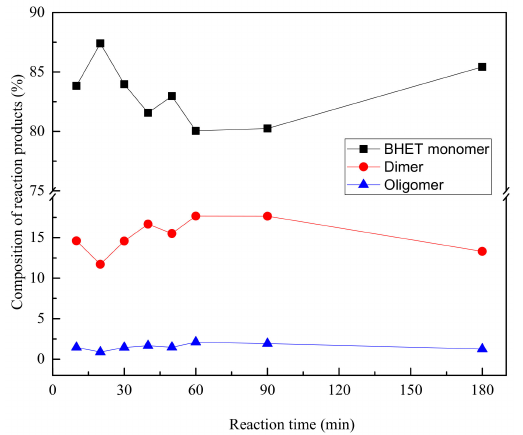
Figure 4. Fractions of different compounds as obtained by GPC at different reaction